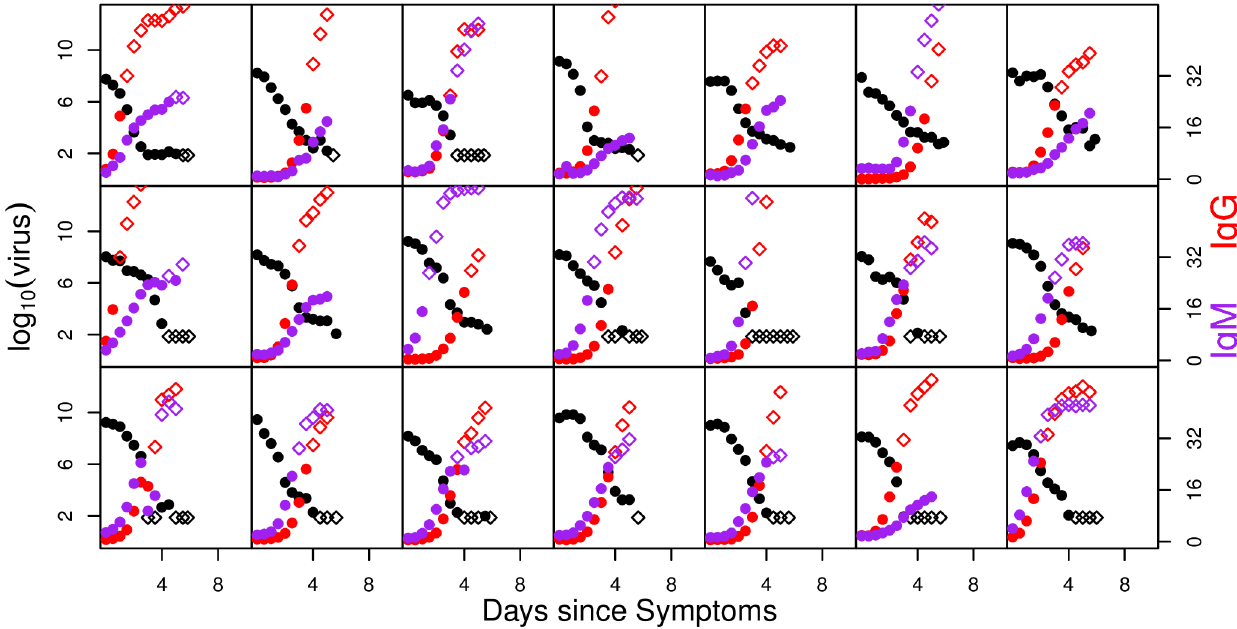
Fig 2. As Fig 1 but for DENV2-infected subjects. The left hand axis shows log 10 viral copies/ml of plasma in black. The right hand axis shows IgG titres in red and IgM titres in purple (both on a linear scale). Each box represents the viral and antibody measurements of a different individual. Unfilled marker symbols show measurements below the assay limit of detection for virus and above the upper limit of reliable (linear) quantification for IgG and IgM [13]. All subjects were classified as secondary infections.